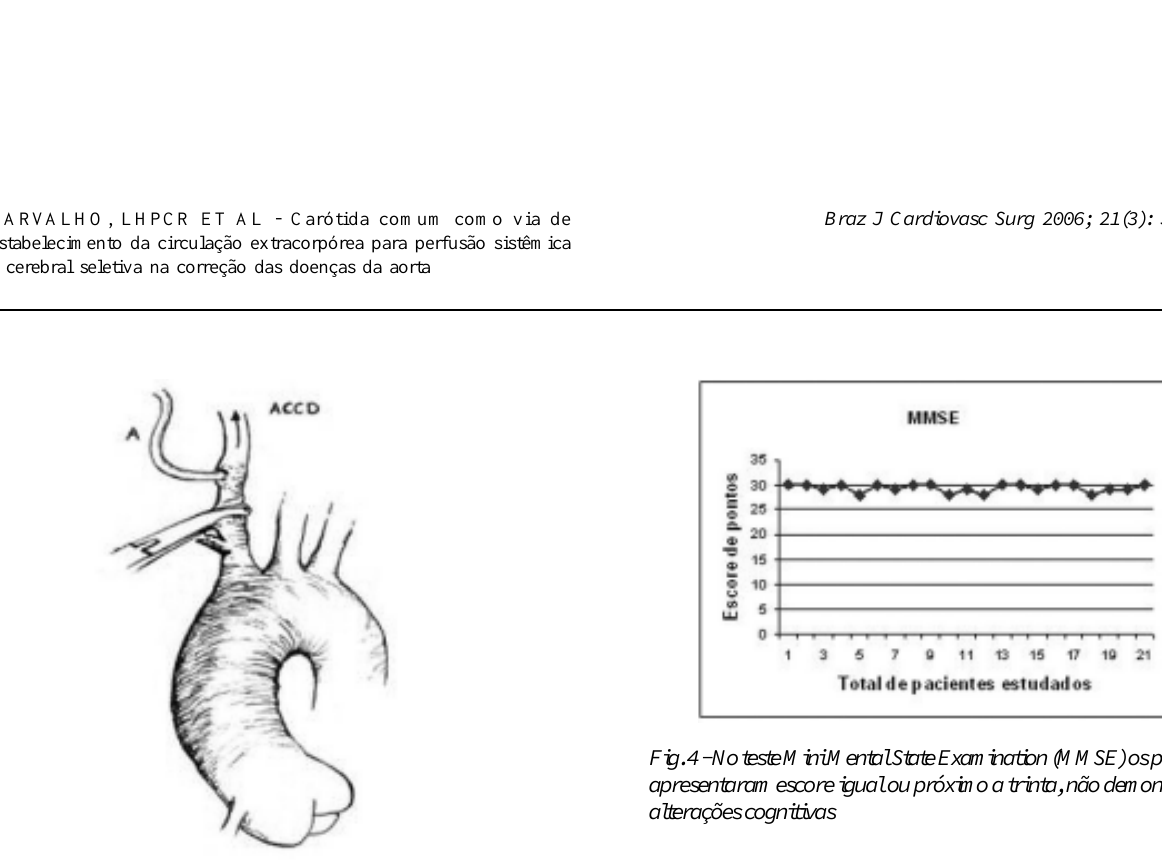
Fig. 3 - Detalhe da posição da pinça na artéria carótida comum direita (ACCD) durante a perfusão cerebral seletiva. A-PTFE